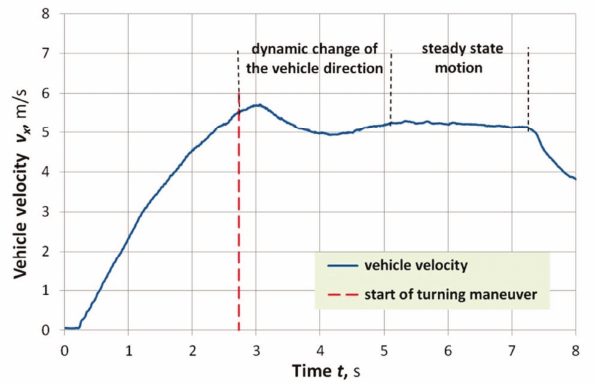
Fig. 11. The run of vehicle motion velocity during the test. [own research]